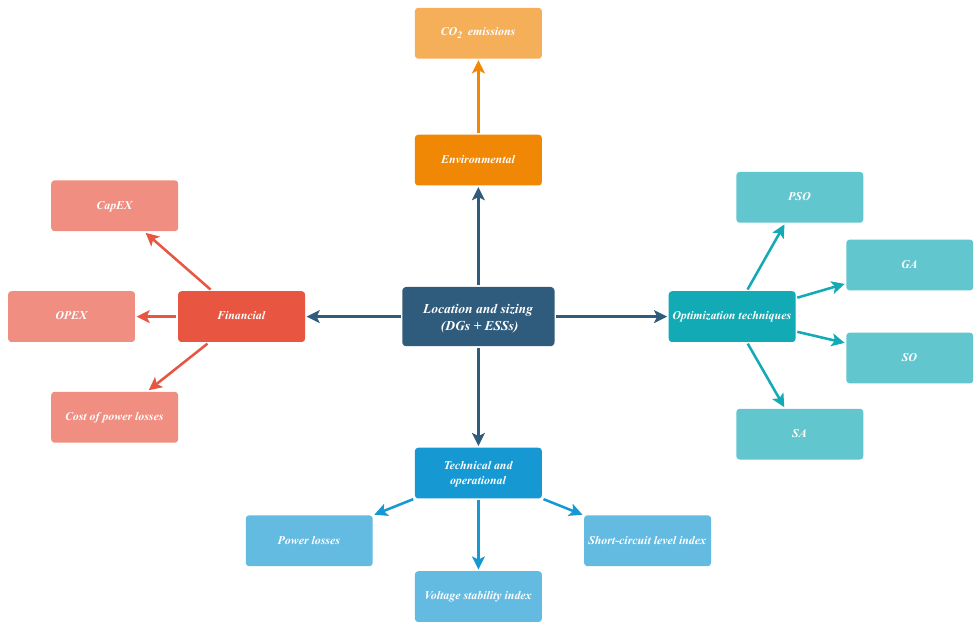
Figure 8. Objective functions and optimization techniques used for the optimal sizing and location of ESSs and DGs into electrical